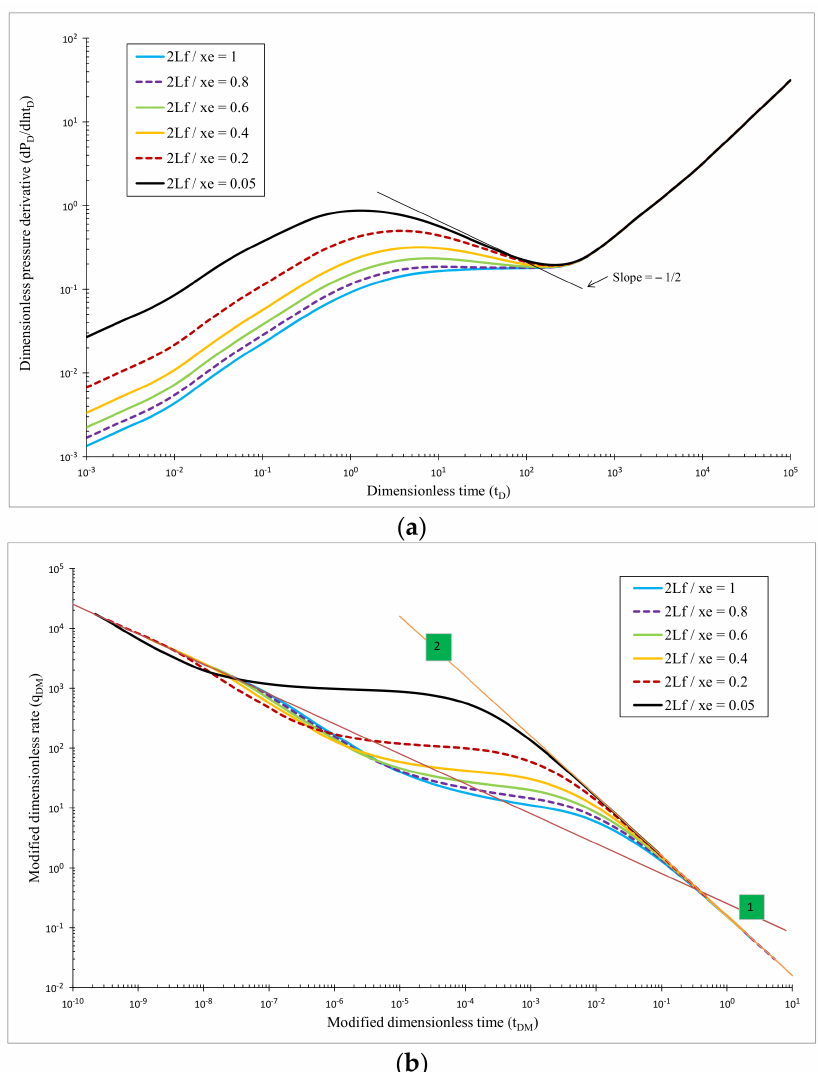
Figure 12. ( a ) Dimensionless pressure derivative dp D / dln ( t D ) vs. dimensionless time t D and ( b ) modified dimensionless rate q DM vs. modified dimensionless time t DM , under various fracture length extension ratios with h f 1 D = h f 2 D = 2, N stage = 10; x e 1 D = x e 2 D = 100, y e 1 D = y e 2 D = 200, h e 1 D = h e 2 D = 100, and M 2 / M 1 = 10 , C S 2 / C S 1 = 1. Fractures assume an identical length